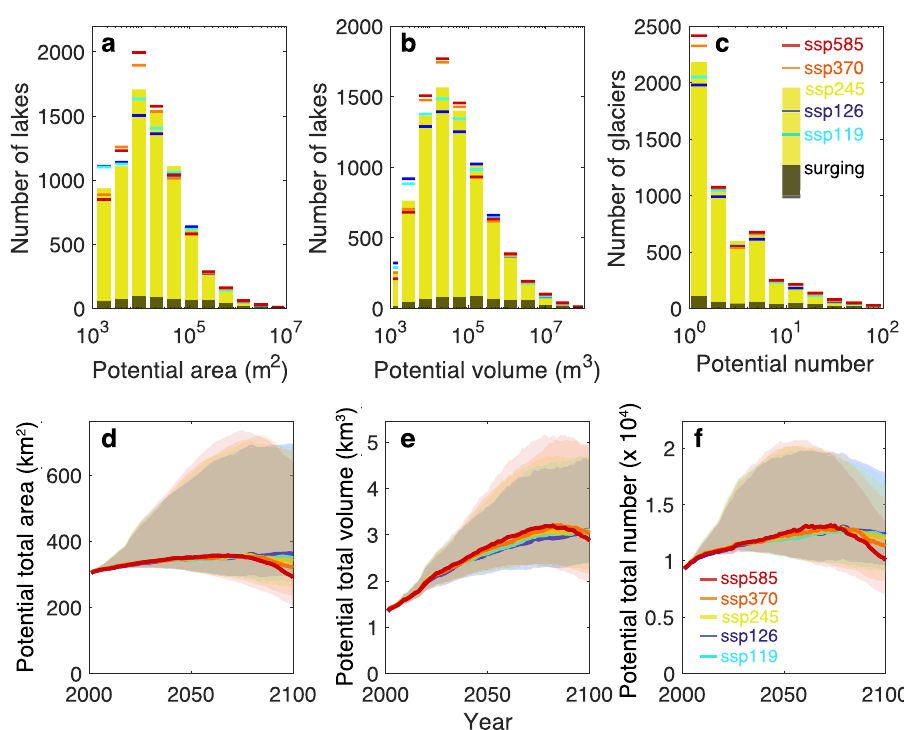
Fig. 3 Size distribution and temporal evolution of ice-dammed lakes across HMA throughout the 21st century. Distributions of the ( a ) area, ( b ) volume, and ( c ) number of ice-dammed lakes are given for the time of modelled maximum lake extent, volume, and number, respectively. Surge-type glaciers are recognised on the basis of the inventory of ref. 68 . Results are divided into SSP scenarios (coloured bars and lines), while surge-type glaciers are displayed by black bars. Evolution of the total ( d ) area, ( e ) volume, and ( f ) number of ice-dammed lakes. The shaded bands depict a 95% con fi dence interval derived from uncertainties in the different model parameters (see